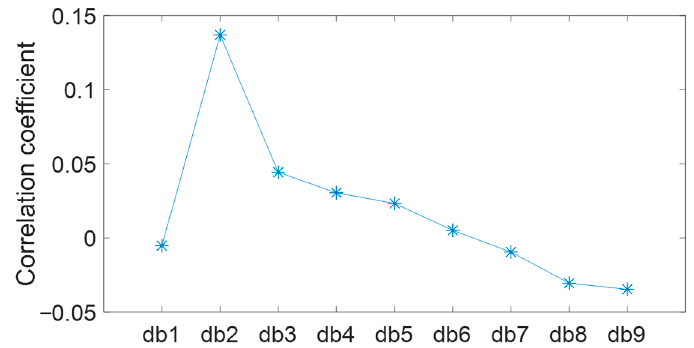
Figure 7. Correlation coefficient for different mother wavelet functions.